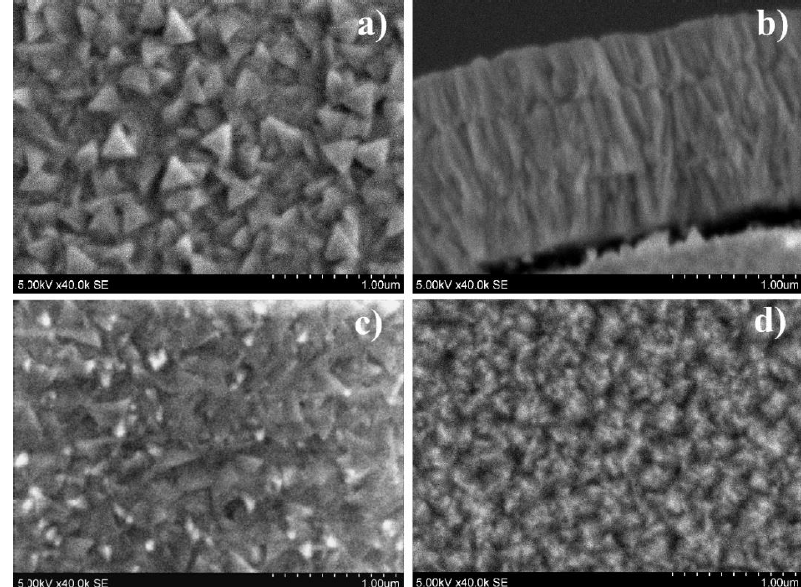
Figure 3. SEM pictures of SDC20 thin ceramic films deposited on 450 °C temperature substrates using deposition rates of ( a ) 0.2 nm/s, ( b ) cross-section 0.2 nm/s, ( c ) 0.8 nm/s, ( d ) 1.6 nm/s.